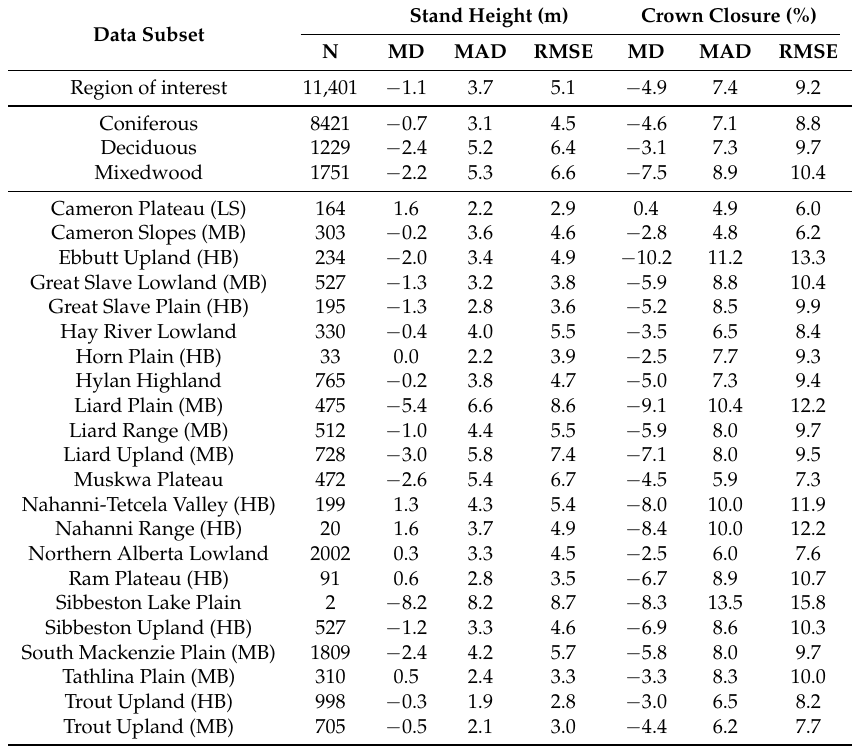
Table 7. Assessment of regionally mapped stand height and crown closure via mean difference. Mean difference was determined by use of all available boreal transect LiDAR plots data across the region of interest, as a function of dominant vegetation type and